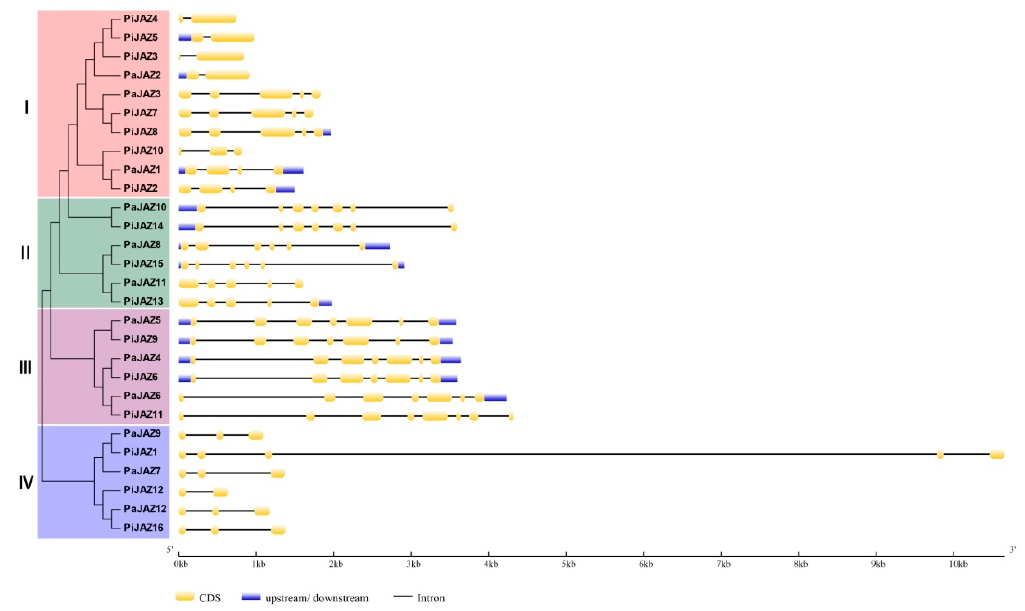
Figure 3. Analysis of gene structure in petunia JAZ genes in the light of the phylogenetic relationship. GSDS database was adopted for exon / intron distribution analysis. Yellow boxes, blue boxes, and black lines indicate exons, upstream / downstream, and introns,